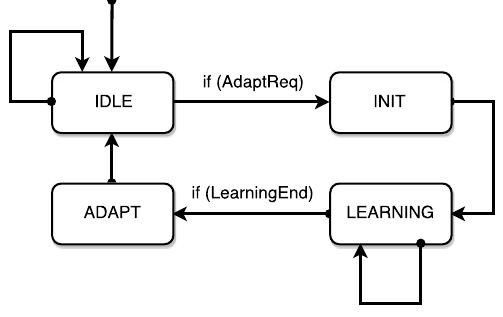
Figure 10. FSM for the sensor sensitivity